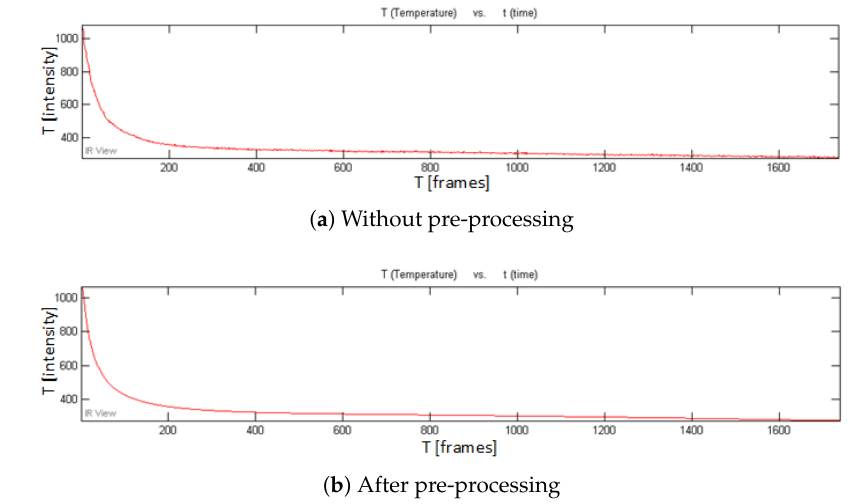
Figure 7. Temperature profile curves (cooling phase) in PT for CFRP 01.